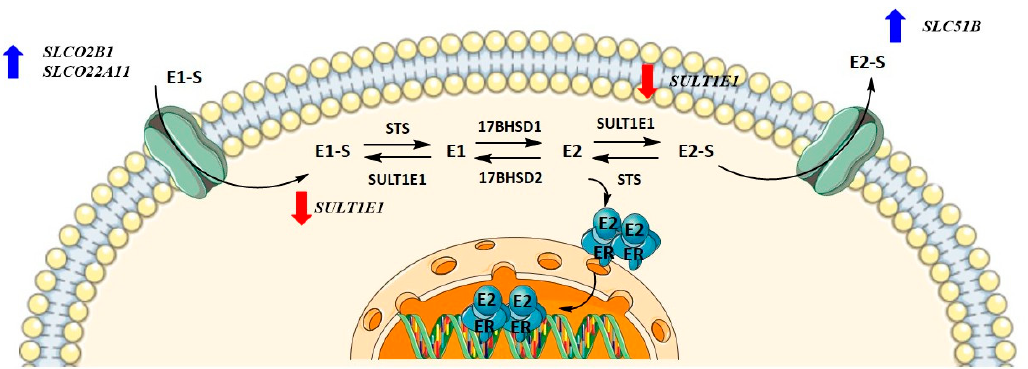
Figure 8. Changes in gene expression levels due to high concentrations of Cimicifuga racemosa extract in the HIO-80 cell line (control cell line of ovarian epithelium).